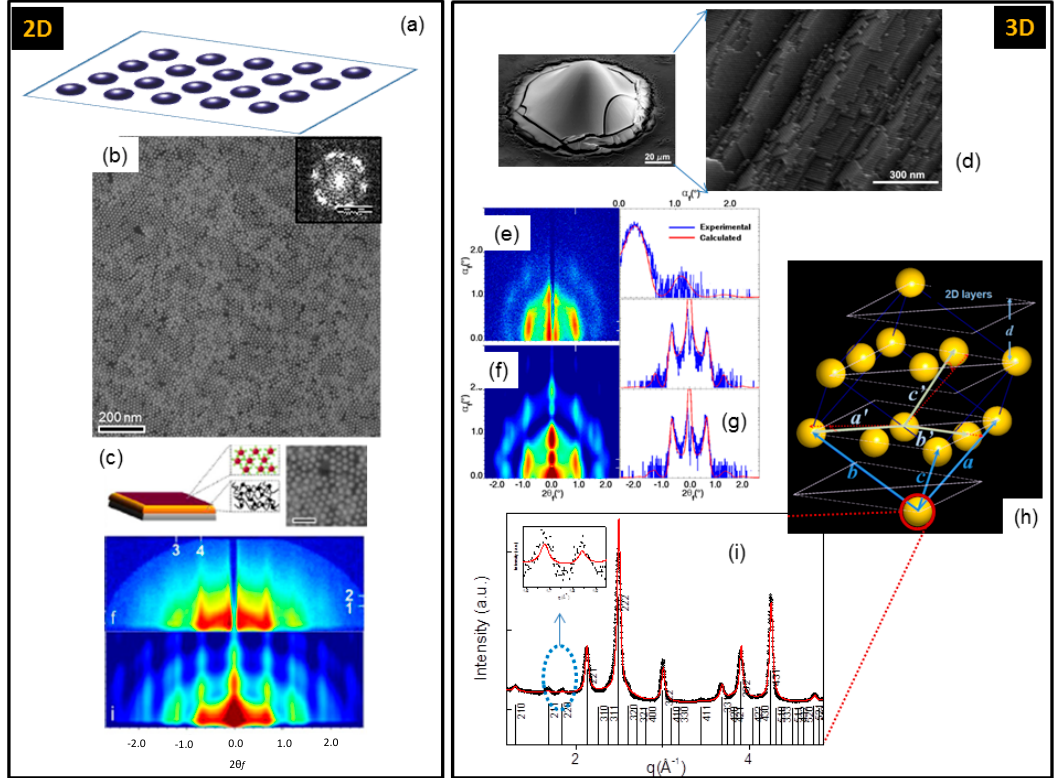
Figure 9. ( a ) a cartoon of a 2D assembly onto a surface; ( b ) Scanning Electron Microscopy (SEM) image of Au nanoparticles (NPs), drop casted onto a teflon functionalized silicon substrate, described by the top inset in ( c ); ( c ) experimental/calculated (upper/lower image) GISAXS data, collected at the XMI-L@b, and a detail of the Au NPs, as observed by TEM; ( d ) cone-shaped island made of iron oxide nanocrystals self-assembled by magnetic field onto a silicon substrate (left) and section of the island, imaged by SEM (right); ( e – g ) experimental and calculated GISAXS data; ( h ) 3D face centered cubic lattice, with (111) planes parallel to the substrate; ( i ) X-ray powder diffraction profile measured from the same sample in ( a ). Dotted curve is the experimental data, red line the fitted profile. The zoom in the inset corresponds to the (211) and (220) peaks with comparable intensities (in the blue circle of Figure 9i) which are characteristic of maghemite structure. Experiments are performed at the MS beamline of the SLS synchrotron source, in reflection mode, with λ = 0.495722 Å. Partially reprinted with permission from reference